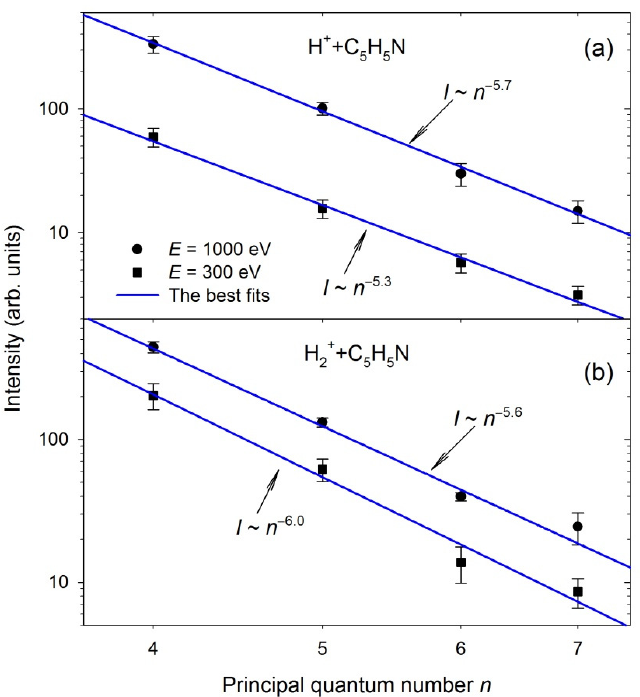
Figure 4. Examples of the log–log plots representing the Balmer line intensities as a function of the principal quantum numbers in the collisions of ( a ) H + + pyridine, ( b ) H 2+ + pyridine. The solid lines show the best fits to the experimental points.